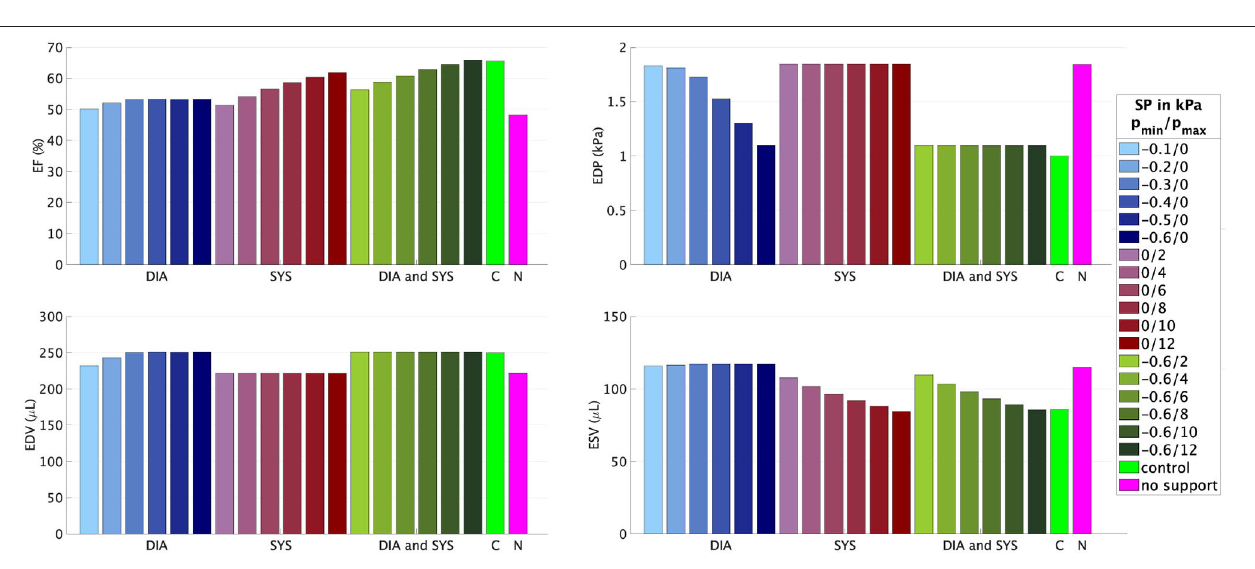
FIGURE 6 | Ejection fraction, EDP, EDV, and ESV for different combinations of the minimal p min and maximal p max values of the support pressure (SP) applied to the epicardial surface of the model with fib = 0.5. DIA, diastolic support (blue); SYS, systolic support (red); DIA and SYS, combined support (green); C, control rat LV (light green); N, rat LV with fib = 0.5 without any support